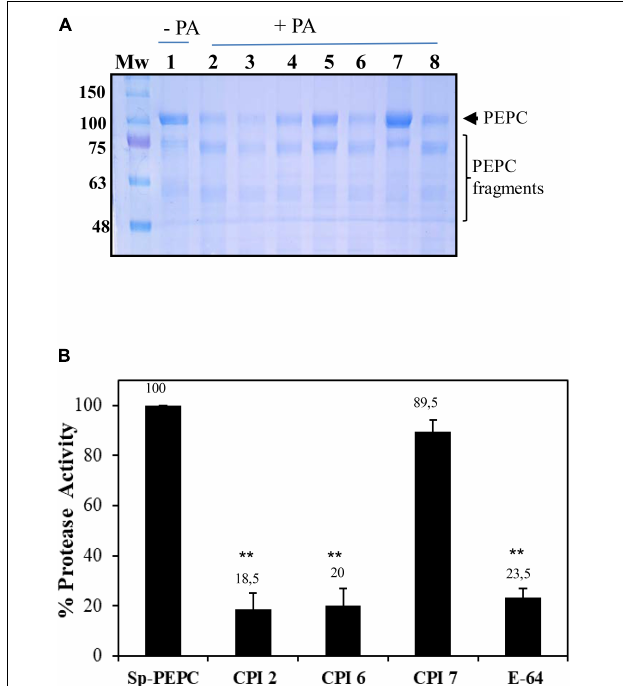
FIGURE 6 | (A) sp-PEPC exposed to PA in the presence of protease inhibitors: sp-PEPC control (lane 1), no protease inhibitors (lane 2), 1 mM Bestatin (lane 3), 0.2 mM Leupeptin (lane 4), 0.065 mM Chymostatin (lane 5), 1 mM PMSF (lane 6), Sigma protease inhibitor cocktail containing AEBSF, 1,10-Phenanthroline, Pepstatin, Leupeptin, Bestatin and E-64 (lane 7) or 0.1 mM Aprotinin (lane 8). Following 20 h of incubation at 30 ◦ C, samples were subjected to SDS–PAGE and stained with Commassie Blue. (B) Cistatin and E-64 inhibit the protease activity present in sp-PEPC. Aliquots of sp-PEPC (25 µ l) were incubated with 1 µ M of recombinant purified cystatin (CIP) or E-64 in a 0.1 M citrate buffer (pH 6), 0.15 M NaCl and 5 mM MgCl 2 for 10 min at 30 ◦ C. Protease activity was assayed by addition of 2 mM of the cathepsin L-specific substrate, Z-FR-AMC. The reaction was developed 5 h at 30 ◦ C. Protease activity is expressed as % with respect to the control in absence of inhibitor (sp-PEPC). Date are the mean ± SE of triplicate measurement and statistically significant difference with respect to the control are indicated by ( ∗ ) at P < 0.05, ( ∗∗ ) at P < 0.01, using the Dunnett test.